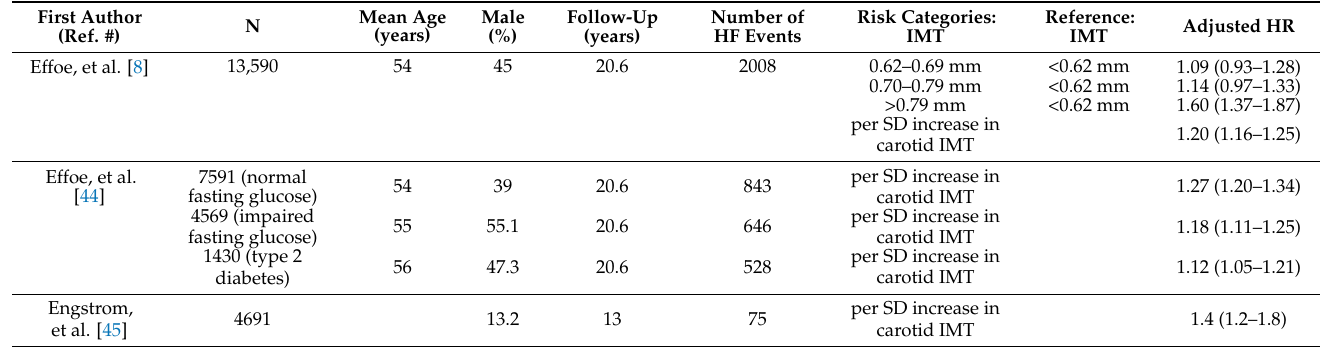
Table 4. The power of carotid intima-media thickness as a risk predictor for heart